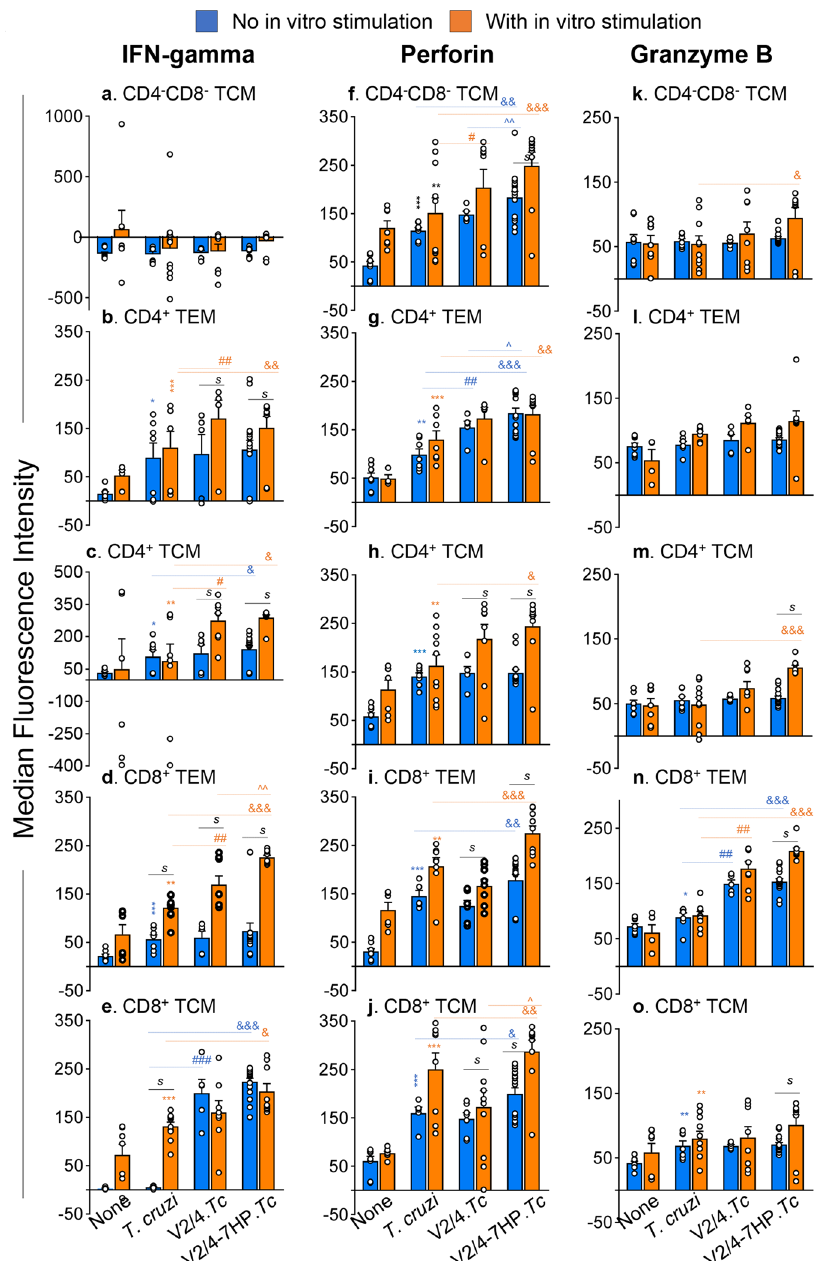
Fig. 4 Effects of 7HP349 adjuvant on vaccine-induced T cells function in T. cruzi infection. C57BL/6 female mice were immunized, challenged, and euthanized as in Fig. 2c. Splenocytes were either used immediately (blue bars) or incubated for 48 h with T. cruzi antigenic lysate (orange bars). Cells were then labeled with fl uorescence-conjugated antibodies and analyzed by fl ow cytometry. The median fl uorescent intensities for IFN- γ ( a – e ), perforin ( f – j ), and granzyme B ( k – o ) in CD4 − CD8 − , CD4 + , and CD8 + T cell subsets with effector/effector memory (TEM) and T central memory (TCM) phenotype are plotted. Data are plotted as mean values ± SEM ( n = 5 – 10 mice per group). Signi fi cance between control vs. infected groups (*) was calculated by unpaired t -test or Mann – Whitney U test. Signi fi cance among infected groups was calculated by 1-way analysis of variance (ANOVA) with Tukey ’ s post-hoc test (comparison of multiple groups) and plotted as # infected vs. V2/4. Tc , ^infected vs. V2/4-7HP349. Tc , and & V2/4-7HP349 vs. V2/4. P values of <0.05, <0.01, and <0.001 are annotated with one, two, and three symbols, respectively. The horizontal bar indicates the compared groups. In some graphs, the horizontal bar with s indicates signi fi cance ( p < 0.05) between matched groups before and after in vitro stimulation. production by CD4 + TEM, CD4 + TCM, and CD8 + TEM subsets was 7HP349 effects on functional activation of vaccine-induced T cells in T. cruzi infected mice increased by 1.59 – 6.19-fold in infected (vs. control) groups, and the maximal increase was noted in V2/4-7HP349. Tc mice Functional analysis of T cell subsets in infected and vaccinated (Fig. 4b – d, Supplementary Table 2, blue bars). A potent increase in mice (±7HP349) before and after in vitro stimulation is shown in IFN- γ production by CD8 + TCM subset (67 – 75.9-fold) was noted in Fig. 4 and Supplementary Table 2. IFN- γ production by DN TCM was negligible (Fig. 4a). Ex vivo analysis showed that IFN- γ vaccinated mice only (V2/4-7HP349. Tc > V2/4. Tc , Fig. 4e, blue bars). Published in partnership with the Sealy Institute for Vaccine